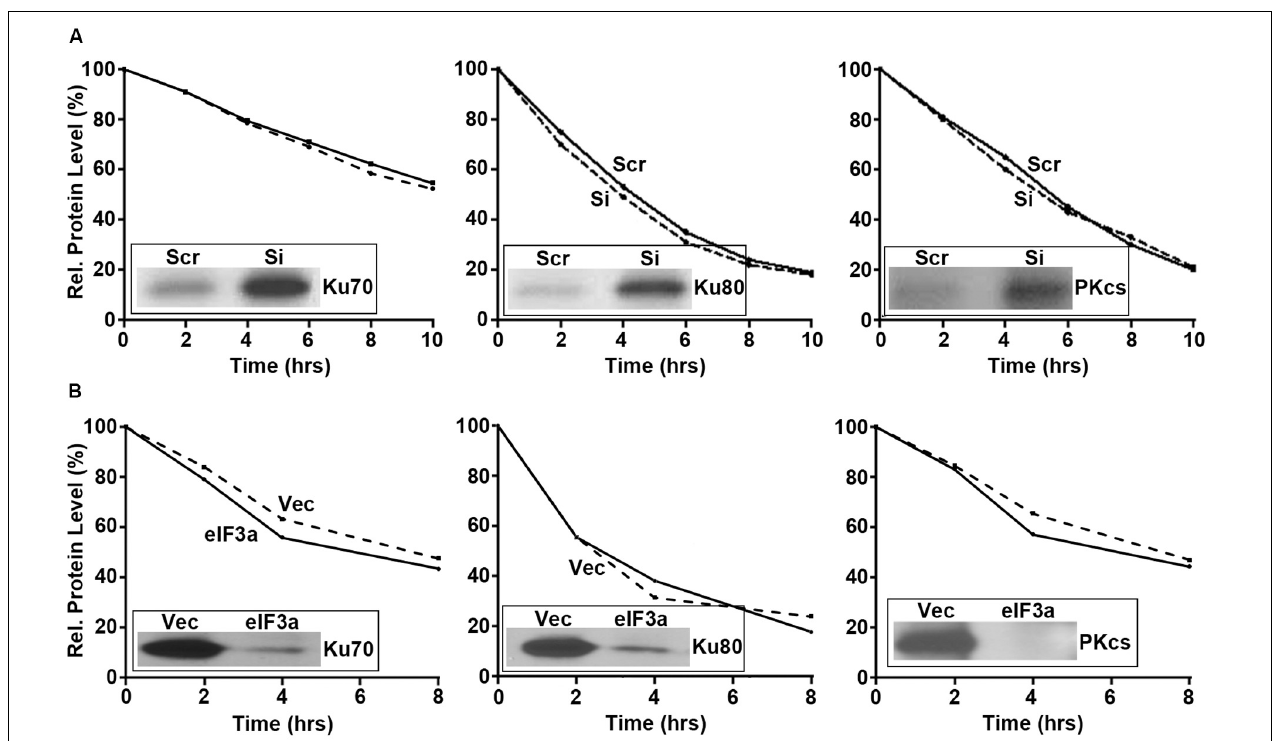
FIGURE 5 | Effect of eukaryotic initiation factor (eIF)3a on the synthesis and degradation of Ku70, K80, and DNA-PKcs. Pulse labeling in combination with immunoprecipitation and cycloheximide chasing were performed to determine the synthesis (insets) and degradation, respectively, of Ku70, Ku80, and DNA-PKcs in H1299 cells with transient eIF3a knockdown (A) and NIH3T3 cells with stable eIF3a overexpression (B) compared with their respective control